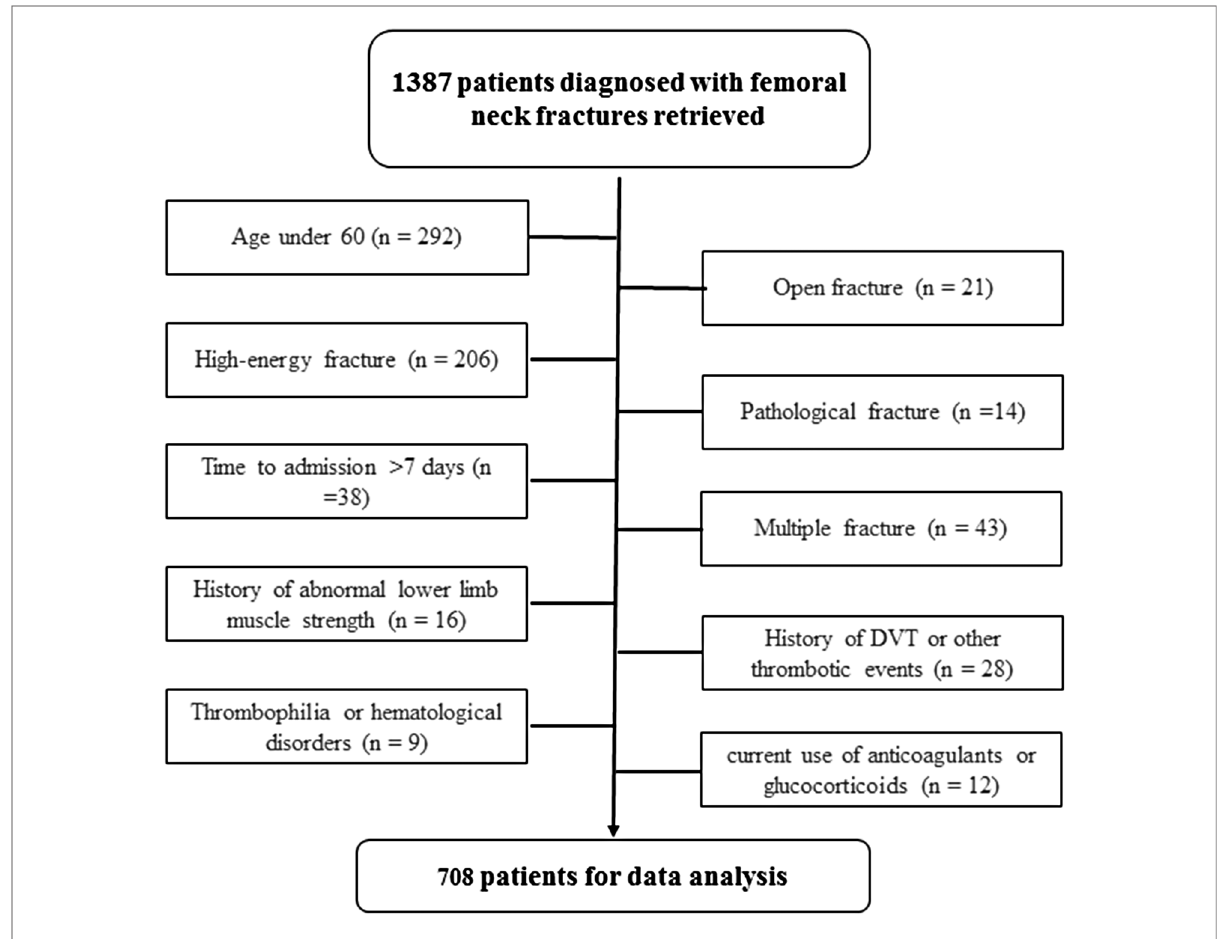
FIGURE 1 Flowchart showing the inclusion and exclusion of